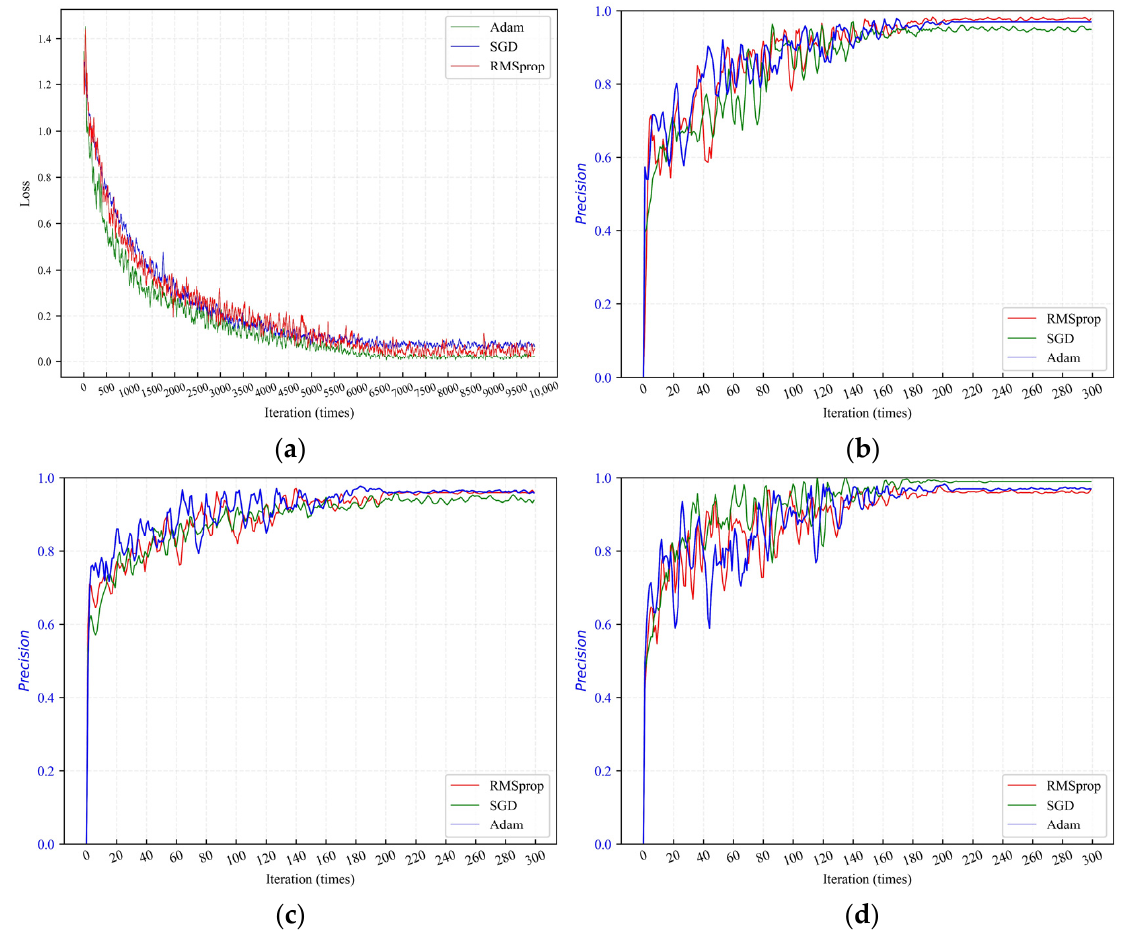
Figure 15. ( a ) Training loss of VGG16 under three optimizers; ( b ) classification precision of metamorphic rock under three optimizers; ( c ) classification precision of sedimentary rock; and ( d ) classification precision of volcanic rock.